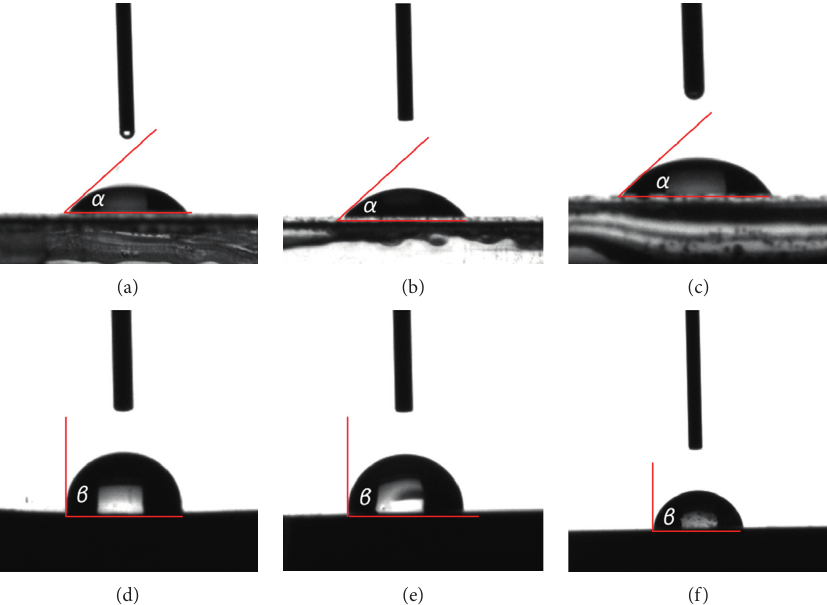
Figure 7: Contact angle of freshly exfoliated minerals substrates ((a) scheelite, (c) fluorite, and (e) calcite) and 1mM sodium oleate solution soaked minerals substrates ((b) scheelite, (d) fluorite, and (e) calcite). (a) scheelite 27.30 ° (b) scheelite 93.60 ° (c) fluorite 36.90 ° (d) fluorite